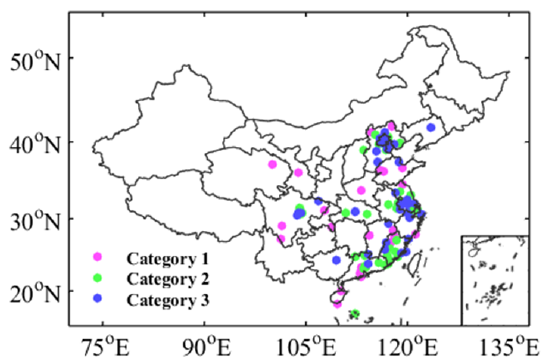
Figure 8. Geographical distribution of RWP sites relative to Aeo- lus ground tracks over China. The magenta, green, and blue solid circles correspond to categories 1, 2, and 3 as displayed in Fig.